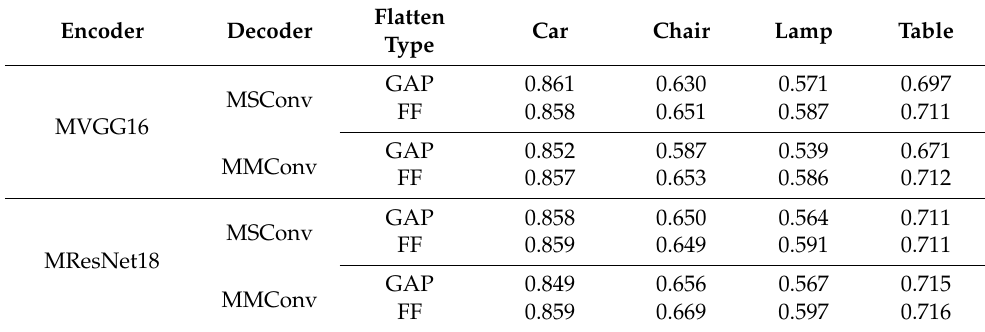
Table 4. IOU values of different encoder–decoder combinations with FF or GAP. Encoder Decoder